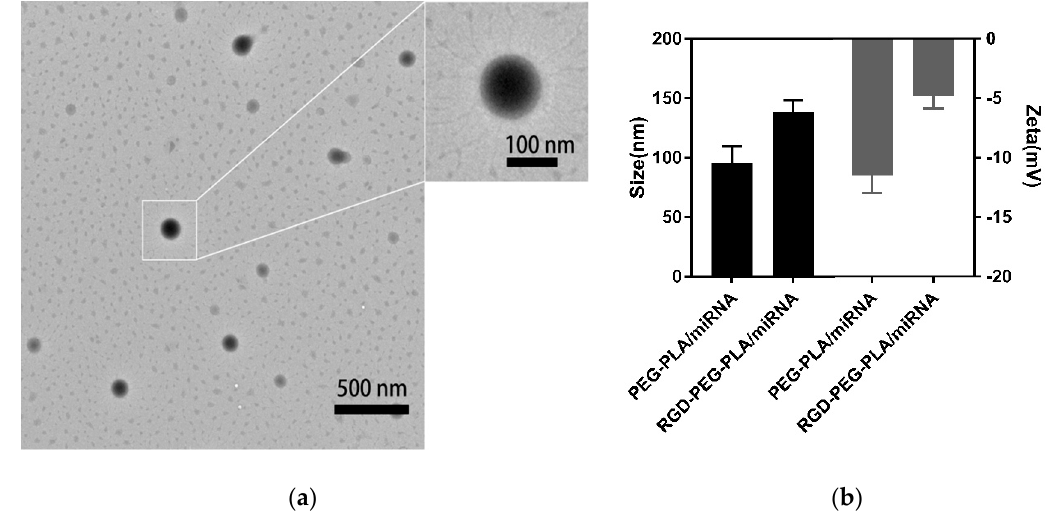
Figure 1. Characterization of nanoparticles. ( a ) Transmission electron microscopy (TEM) image of arginine-glycine-aspartic acid tripeptide (RGD)-polyethylene glycol (PEG)-polylactic acid (PLA) / microRNA-133 (miR-133). ( b ) The average particle size and surface zeta potential of PEG-PLA / miR-133 and RGD-PEG-PLA/miR-133.